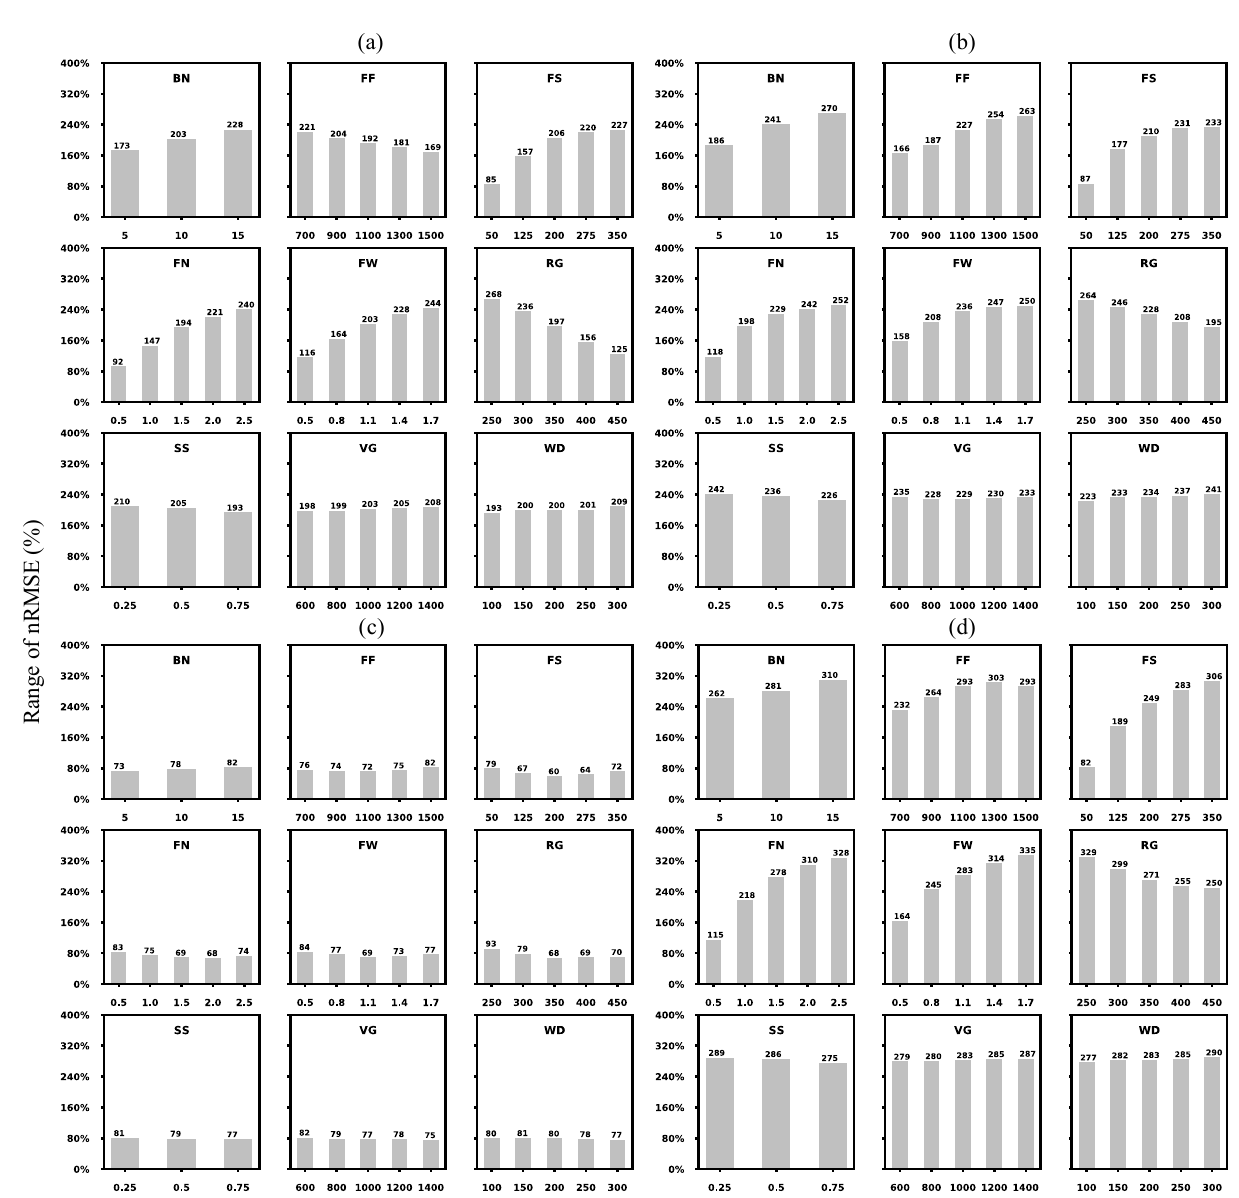
Figure 3. Range of STICS model prediction uncertainties (nRMSE, %) based on the combined variable (i.e., objective function) under each parameter value (fix a given parameter value and test the remaining combinations). ( a ) Touriga Nacional (TN) with the single-cordon training system; ( b ) Touriga Nacional (TN) with the double-cordon training system; ( c ) Touriga Franca (TF) with the single-cordon training system; ( d ) Touriga Franca (TF) with the double-cordon training system. The range (spread) is calculated as four times the inter-quartile range (the associated boxplots are shown in Figures S2–S5).